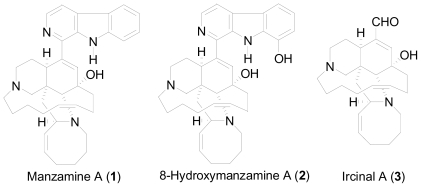
Manzamine alkaloids.